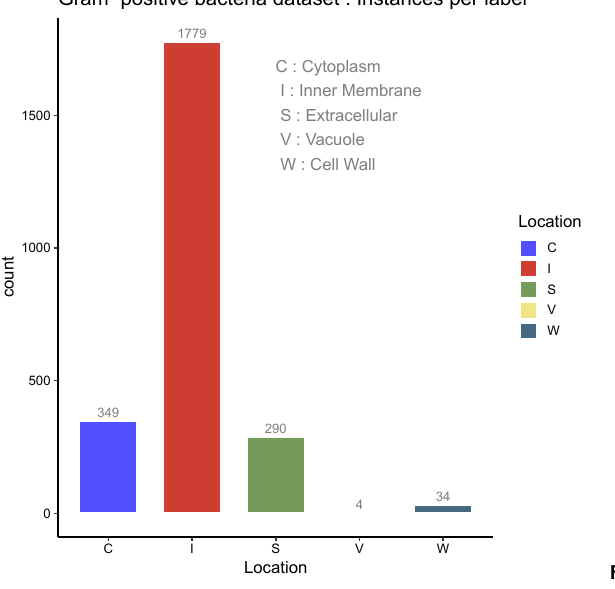
Figure 3: Gram-positive bacteria